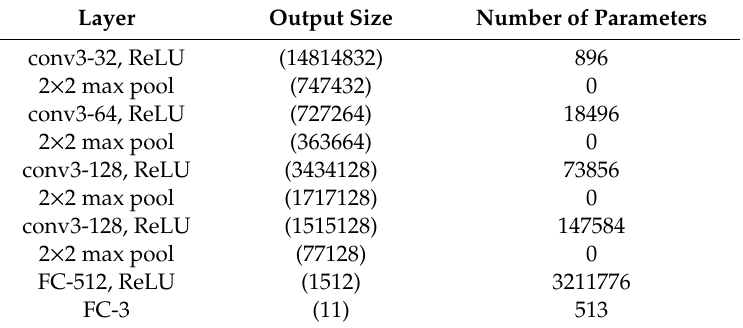
Table 1. The architecture of the convolutional neural